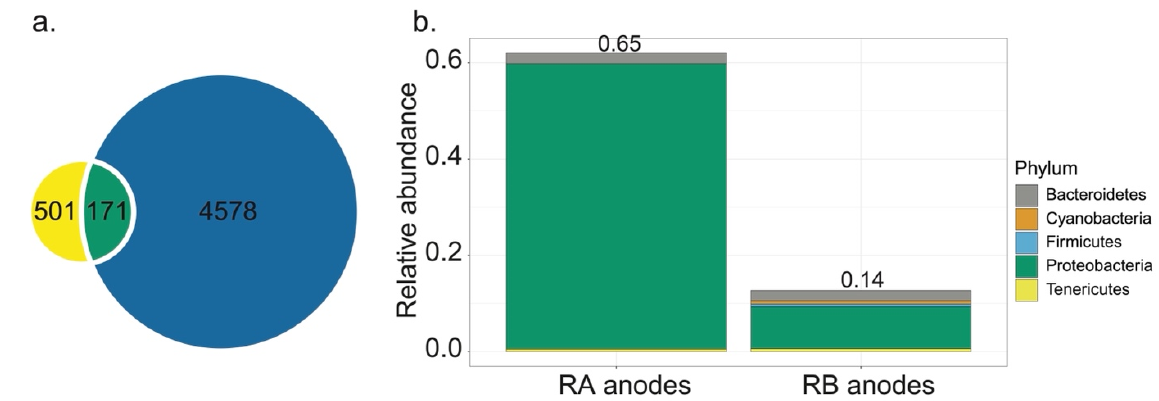
Figure 3. ( a ) Venn diagram of the common members of anodic communities in reactor A and B. A total of 171 amplicon sequence variants (ASVs) are shared. ( b ) The relative abundance of the shared taxa in each sample.